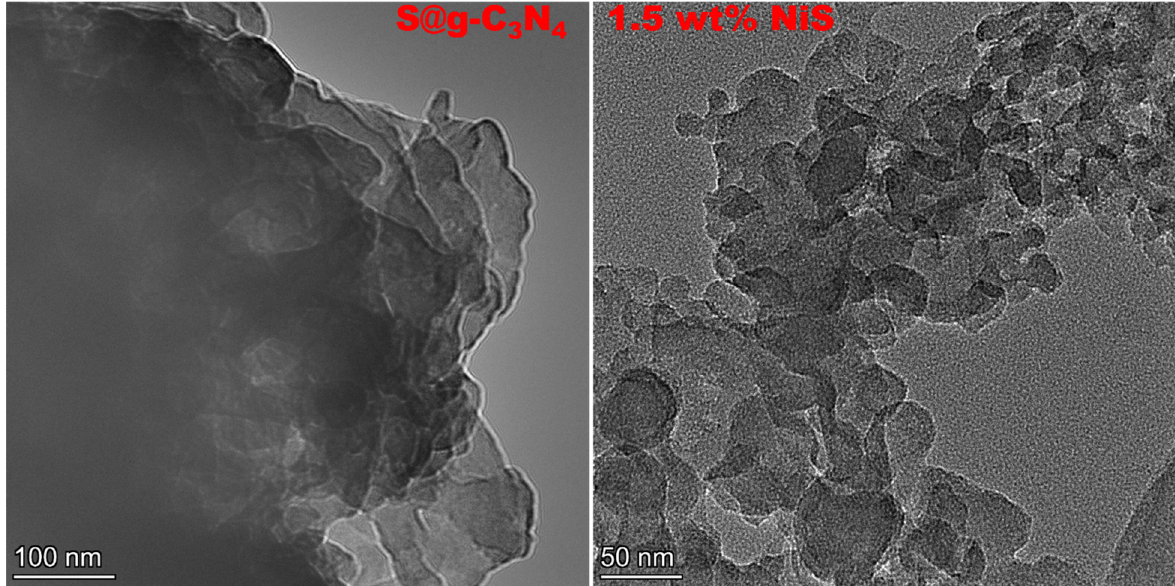
Figure 4. TEM micrographs of S@g-C 3 N 4 and 1.5 wt.% NiS nanocomposites.